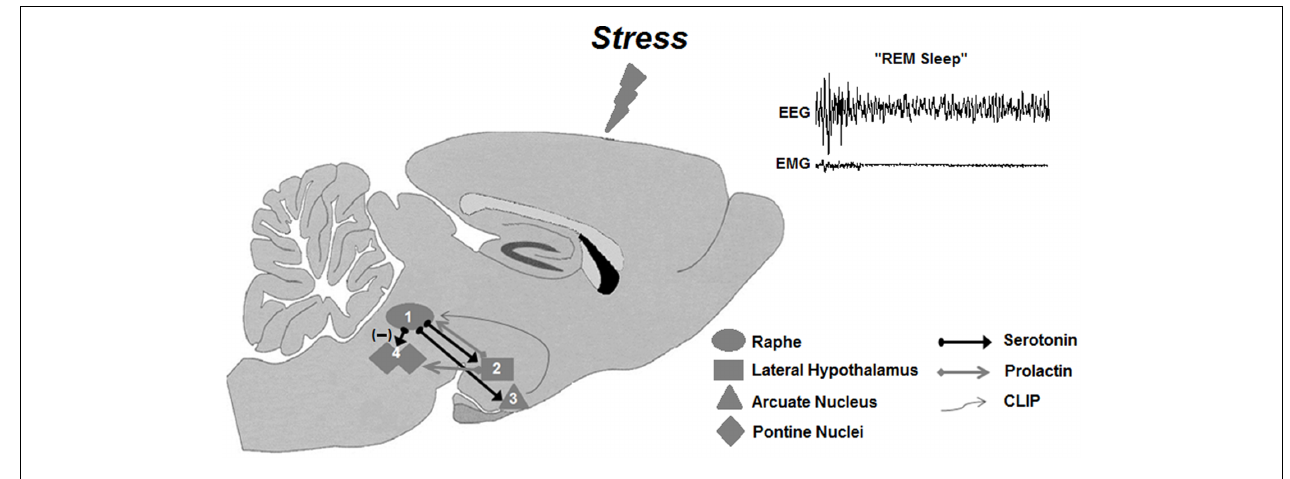
projection to the arcuate nucleus – Arc (3) stimulates POMC cleavage resulting in production and secretion of CLIP in this region. Descending projections from the Arc to the Raphe nuclei would lead to accumulation of CLIP in this area, inhibiting serotonin secretion, thus releasing the cholinergic activity in pontine nuclei (4), leading to REMS. PRL would also produce excitation of pontine cholinergic neurons, contributing to the expression of REMS